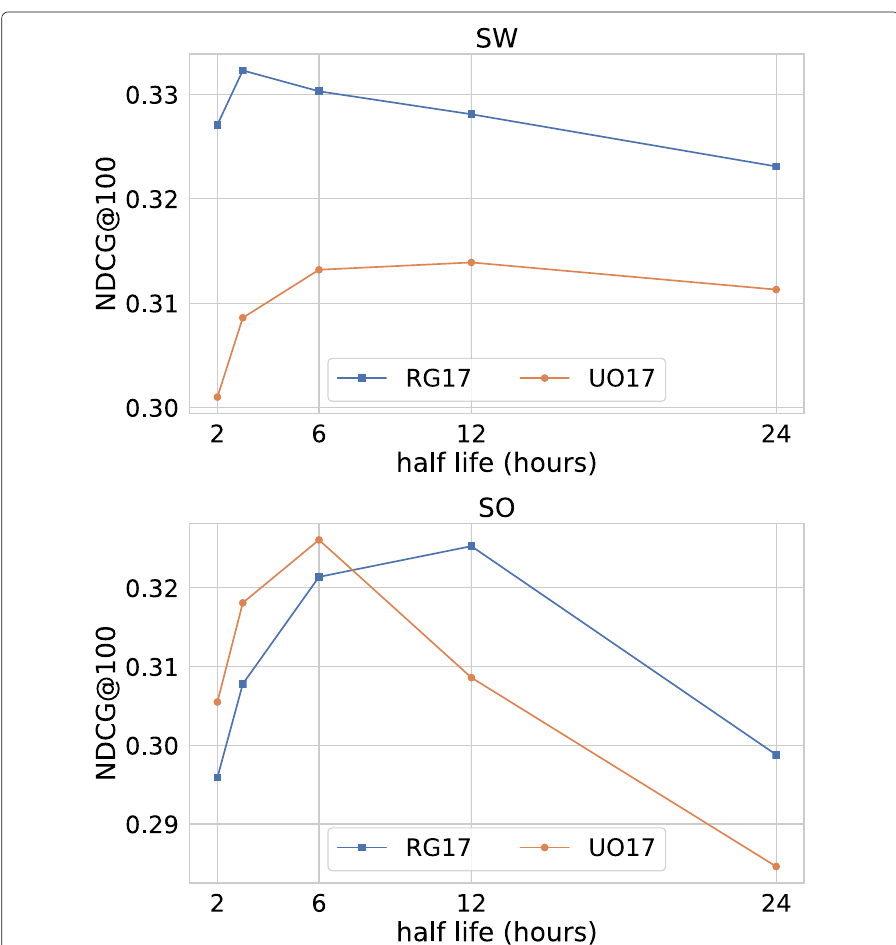
Fig. 10 The effect of half-life on the global mean performance (NDCG@100) of StreamWalk ( top ) and online second order similarity ( bottom